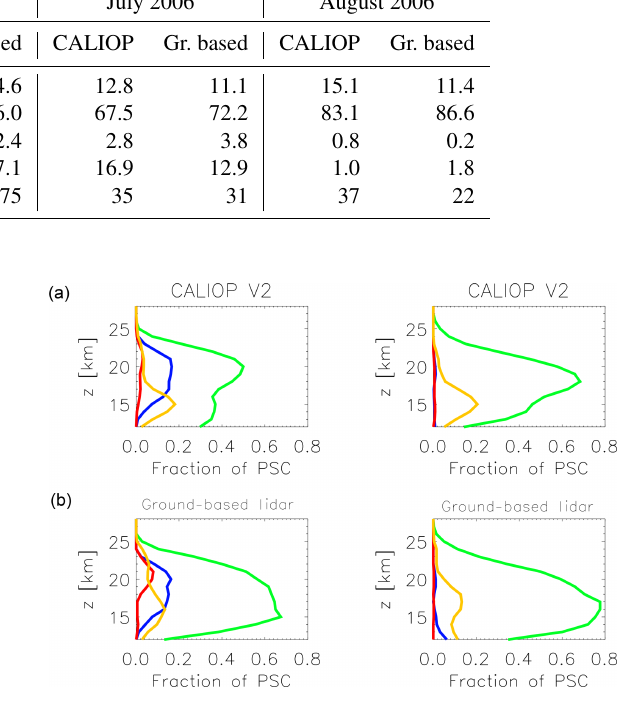
Figure 3. The PSC vertical distribution for the 2006 winter as a fraction of the total observations for the four PSC classes (orange denotes STS, green denotes NAT mixtures, red denotes enhanced NAT mixtures and blue denotes ice), the two columns indicate the months of July and August (from left to right). (a) CALIOP v2 prod- uct. (b) Ground-based lidar at